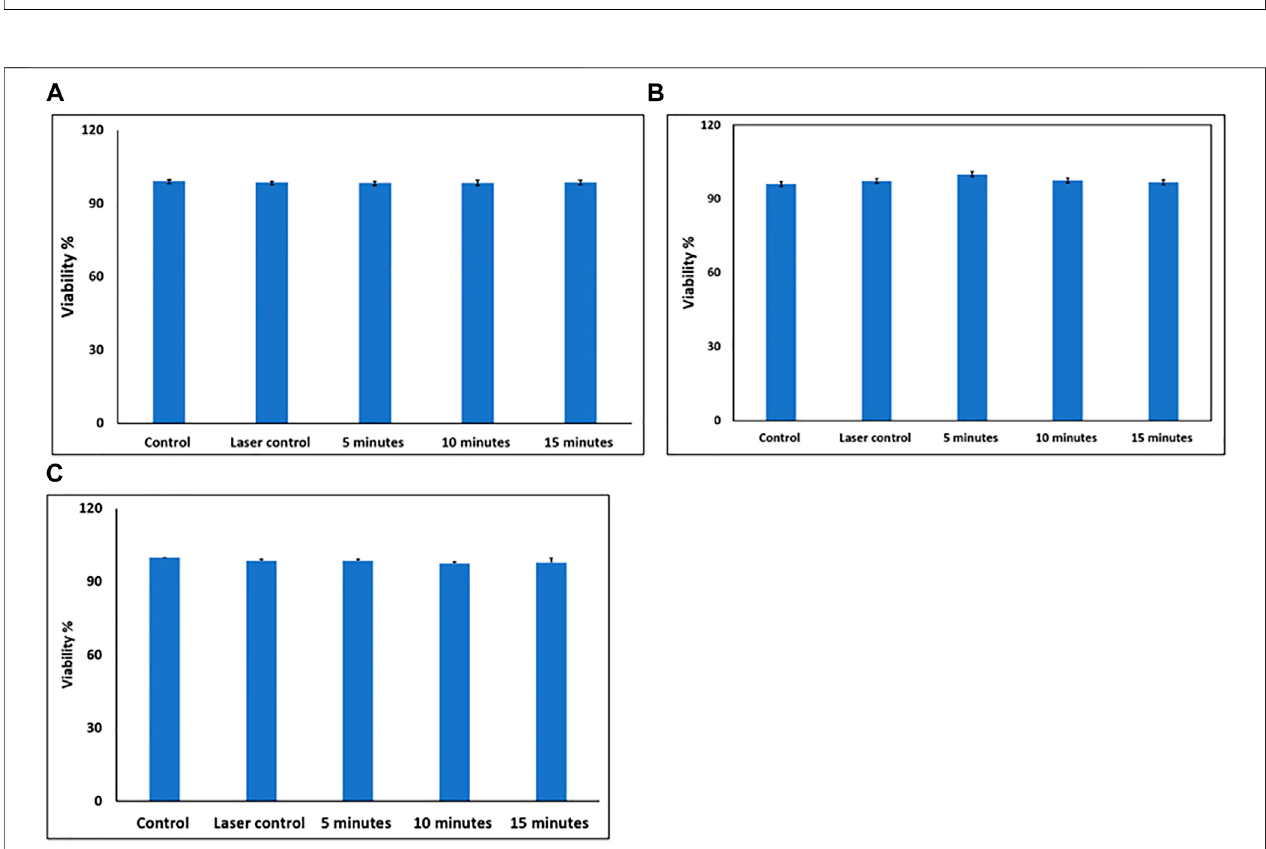
FIGURE7|(A) Cellviabilityafter exposuretoPD (cid:1) 1 W/cm 2 fordifferentdurations(5, 10,and15 min). (B) Cellviabilityafter exposuretoPD (cid:1) 3 W/cm 2 fordifferent durations (5, 10, and 15 min). (C) Cell viability after exposure to PD (cid:1) 5 W/cm 2 for different durations (5, 10, and 15 min).